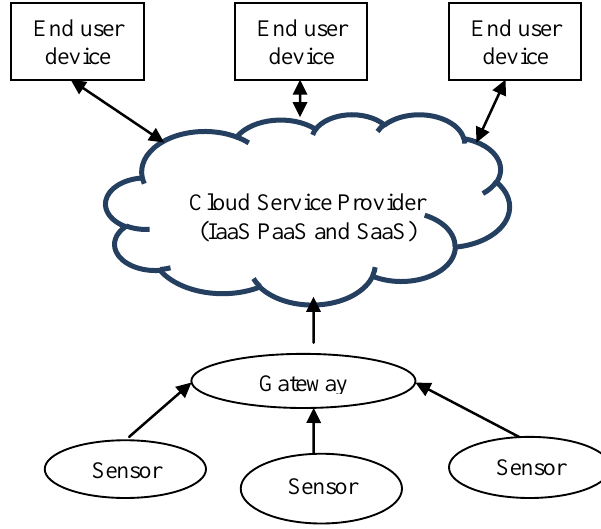
Figure 1. Conventional Sensor Cloud